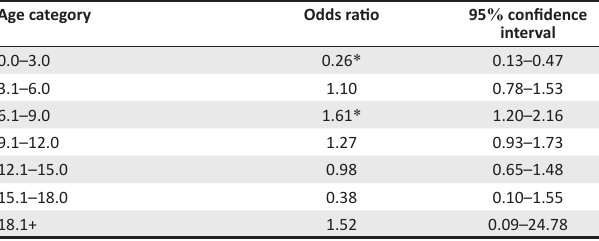
TABLE 3: Odds ratios with their confidence intervals for lymphoma in the different age categories of the IDEXX population. Age category Odds ratio 95 % confidence